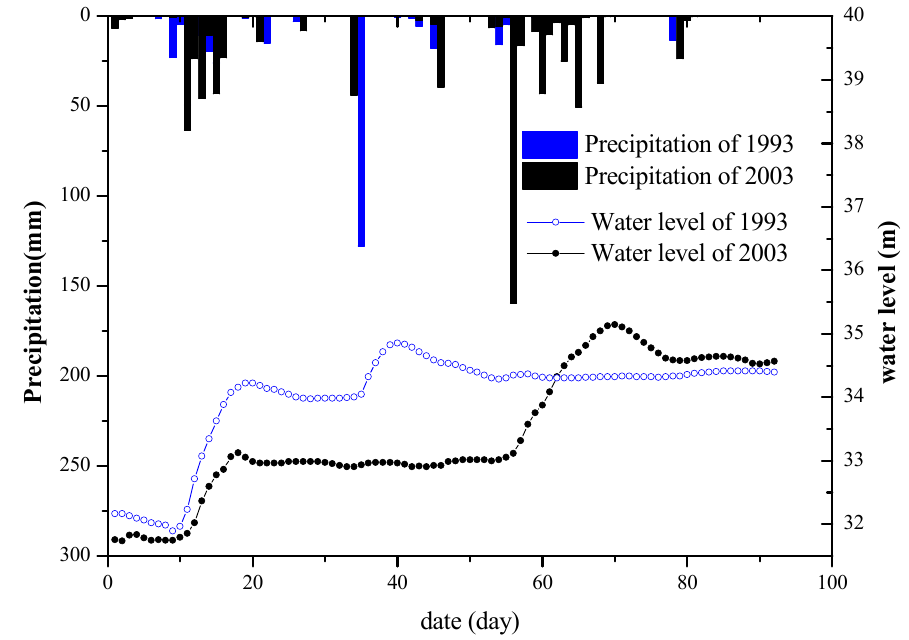
Figure 7 . The water level variations at Nanyang station in typical years.